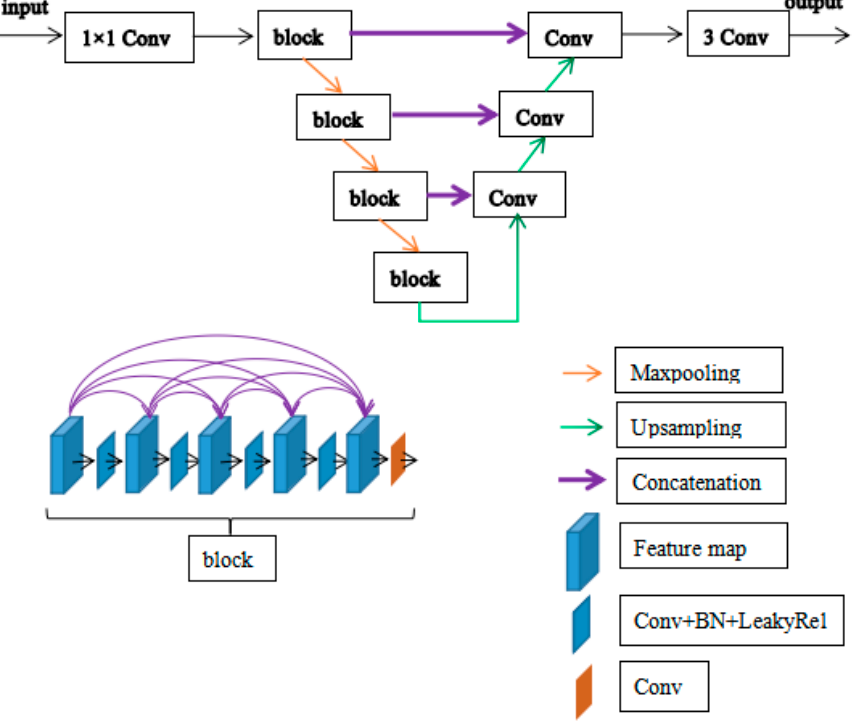
Figure 3. The network design of Generator 1 consists of an encoder and a decoder. The encoder extracts features using 4 dense blocks of convolution, batch normalization, and Leaky-Relu. The feature maps are then upsampled by the decoder to produce the output.